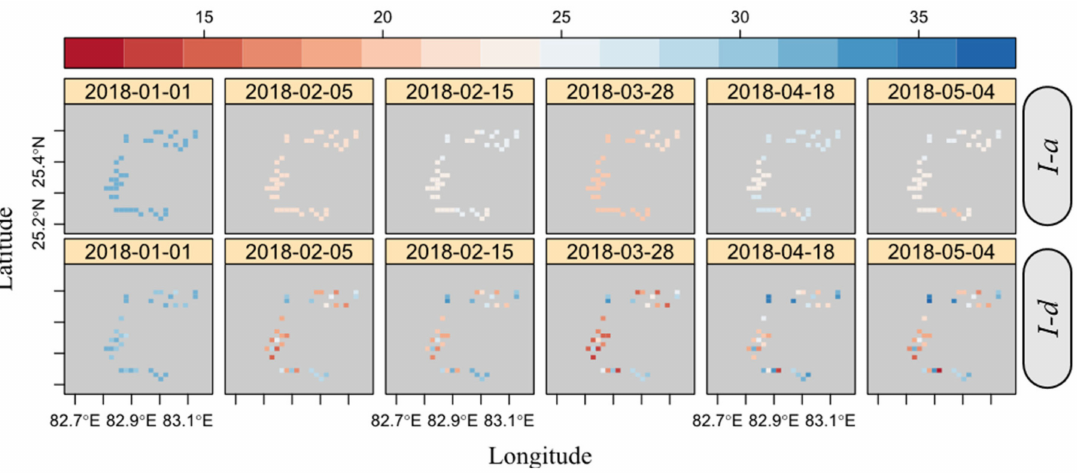
Figure 13. Modelled RZSM simulations for six days during the study period. The simulated I-a and I-d RZSM for 44 locations in the study area are